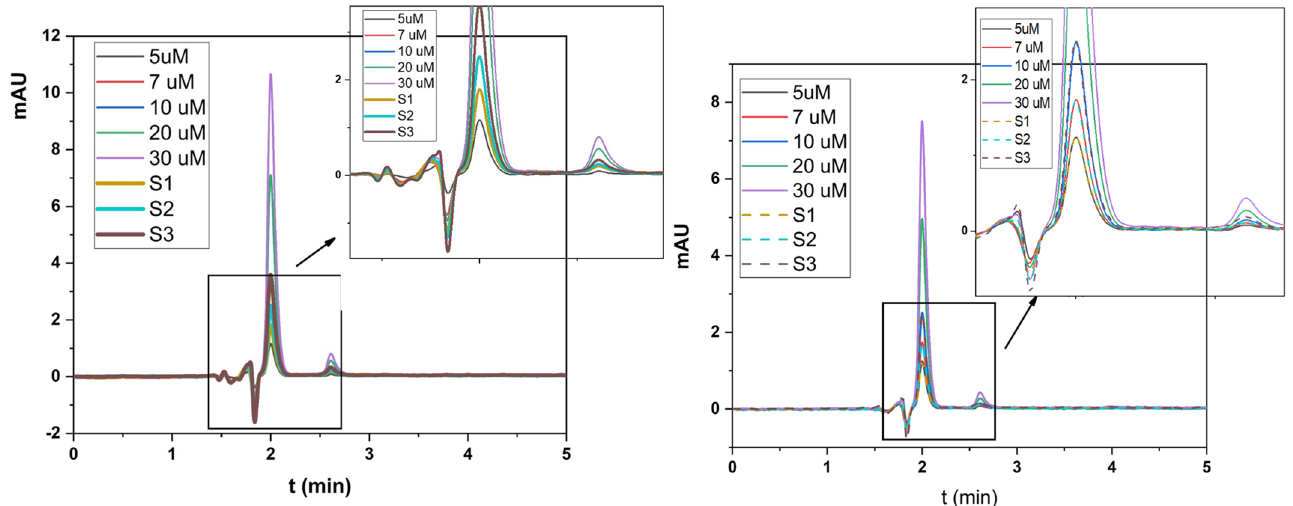
Figure 8. HPLC chromatograms obtained for morphine standard solutions and tested samples. Table 2. Results for MORPH detection in urine samples.